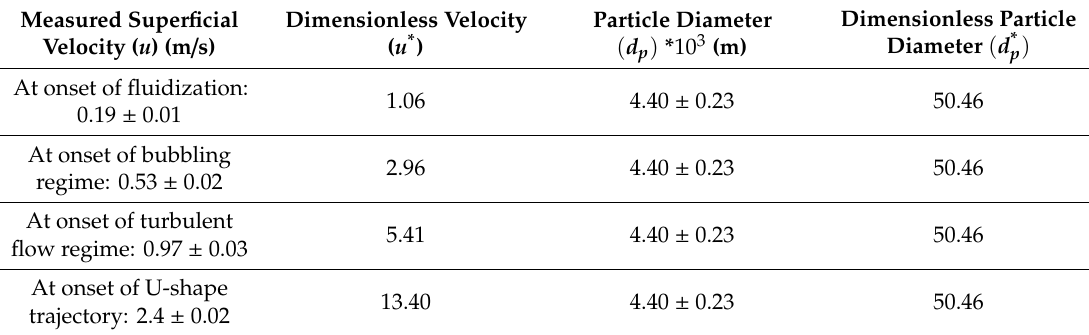
Table 5. The particle diameter, measured superficial velocities, calculated d p * and u * for Run #9. Dimensionless Particle Measured Superficial Dimensionless Velocity Particle Diameter ( d p ) * 10 3 (m) Diameter ( d * p Velocity ( u ) (m / s) ( u * )